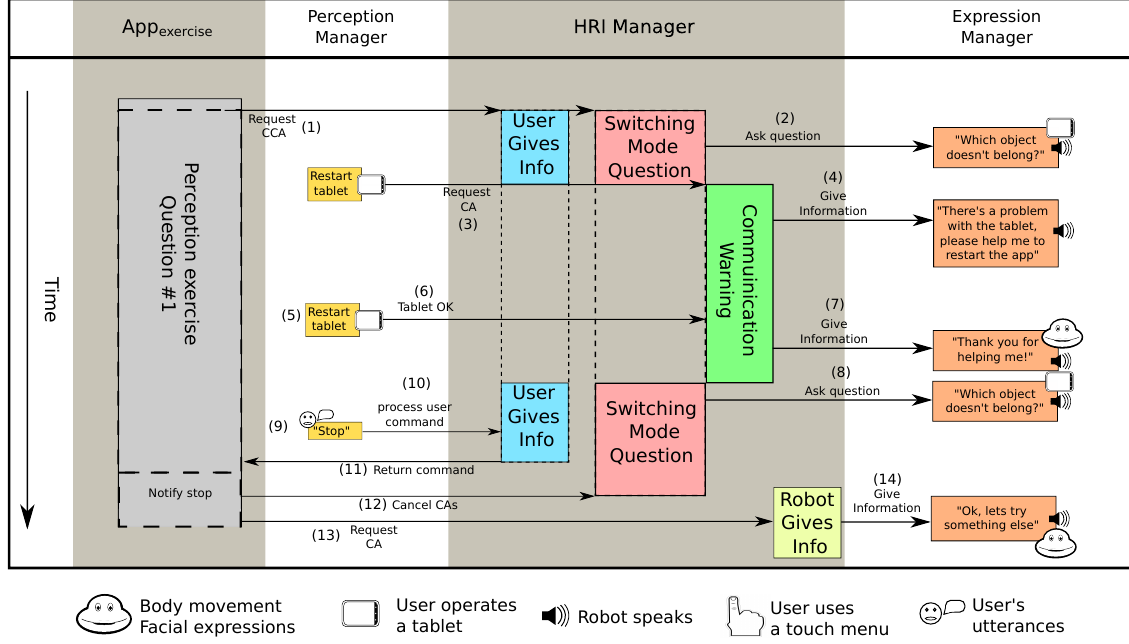
Figure 12. Fourth question of the exercise. The boxes represent actions performed by the different agents and the arrows represent the connections between these actions. Numbers will be referenced in the text to help the